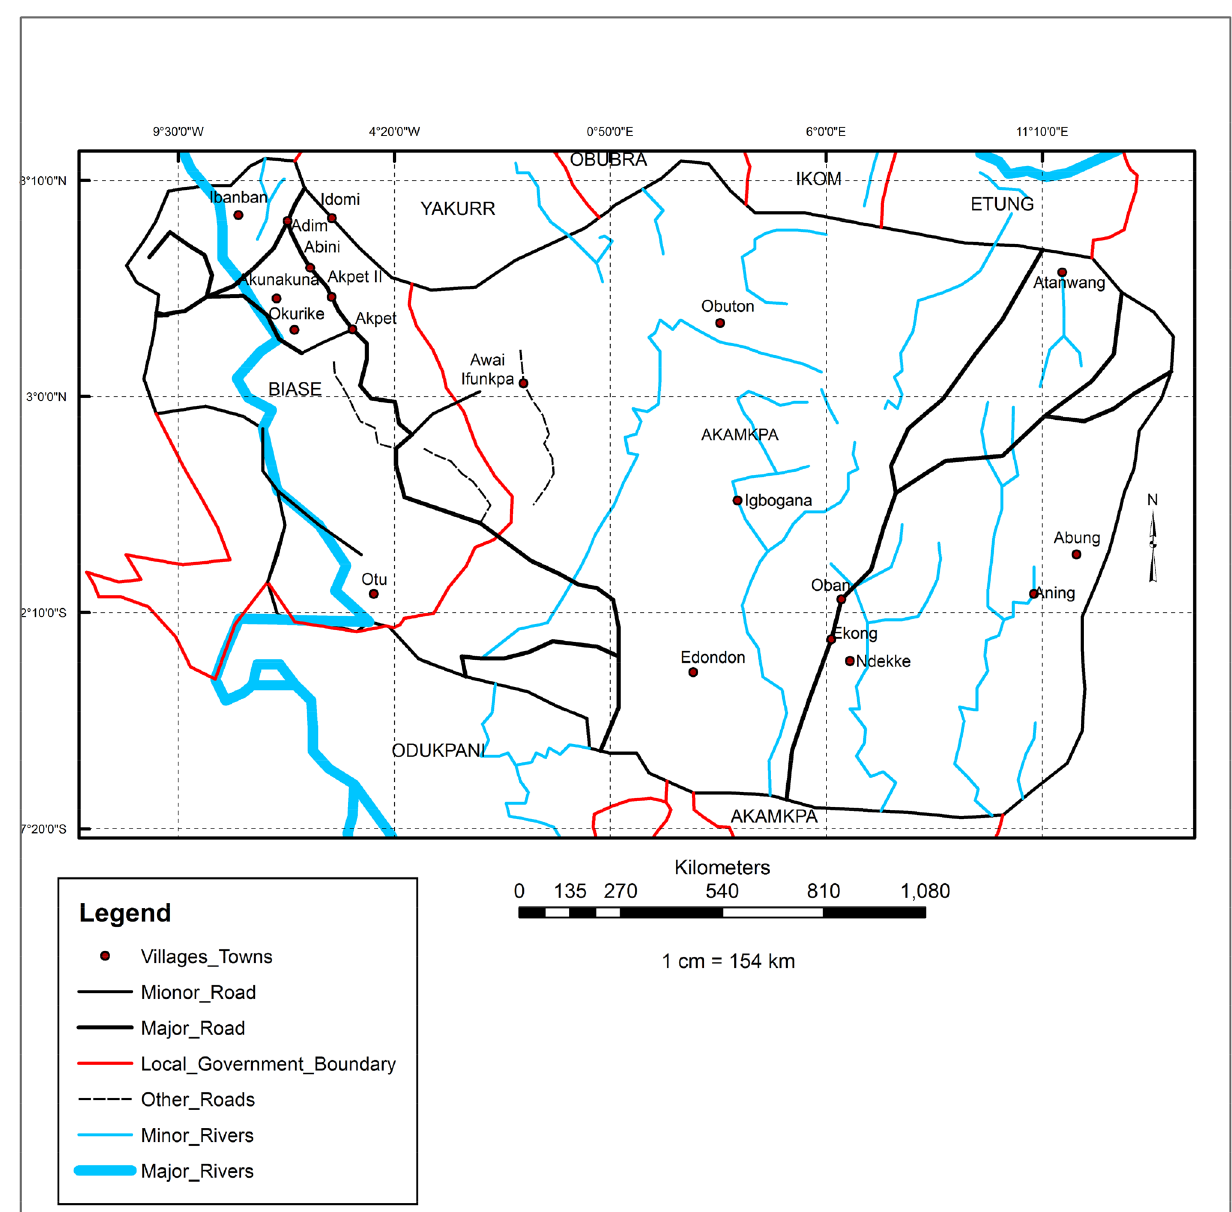
Fig. 1 Location map of the study